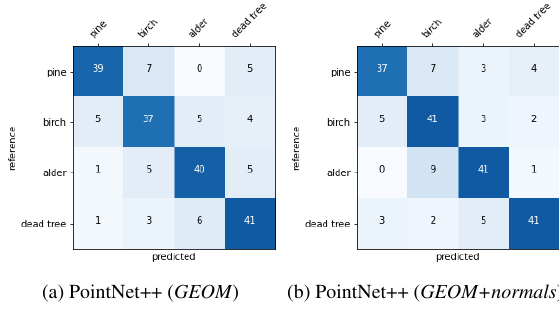
Figure 6. Confusion matrices on the test dataset using only geometry information and PointNet++ exclusive (a) and inclusive of (b) surface